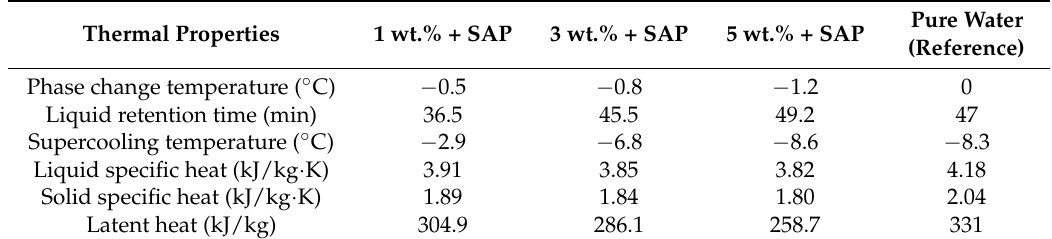
Table 3. Summary of thermal properties of PCMs with different eutectic molten salt concentrations; 1 wt.%, 3 wt.% and 5 wt.% with